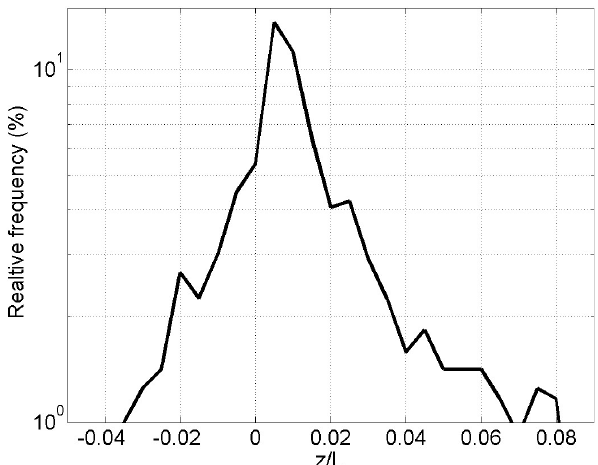
Fig. 5. Significance of particle number gradient in profile data: (a) individual data points of normalized particle number con- centration, (b) normalized particle number concentration averaged at each height with the standard deviations as the error bars, and (c) the difference between adjacent means from left to right with ± twice the standard errors as the error bars.